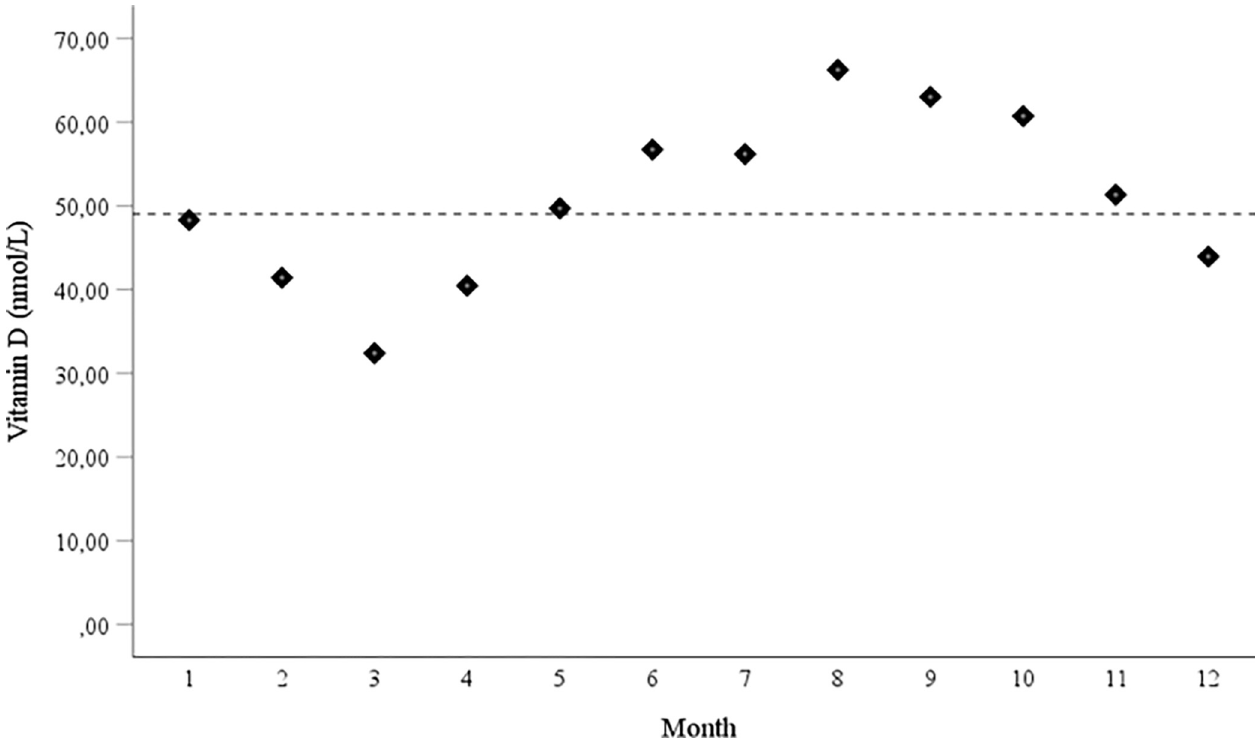
Fig 1. Median concentrations of vitamin D (25-hydroxyvitamin D3) divided after estimated month of sampling in early pregnancy among the controls. The number of controls per month varied between 40 and 64. The median for the whole period is also shown.